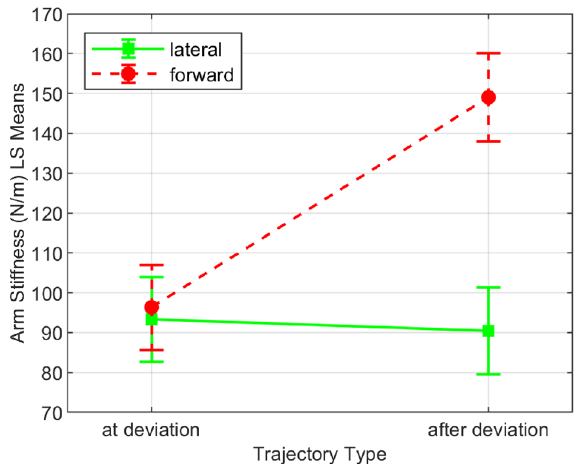
Figure 7. The effects of perturbation direction on the arm stiffness (least square means, 95% confidence interval) based on the condition, in all